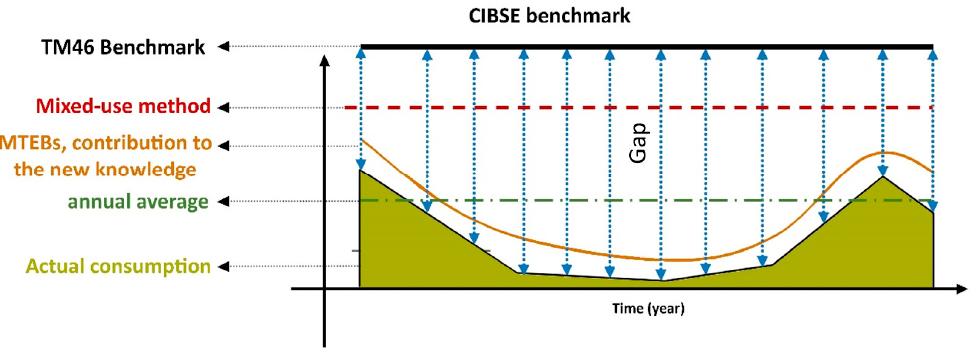
Figure 2. Monthly thermal energy benchmarks (MTEBs) ideogram.